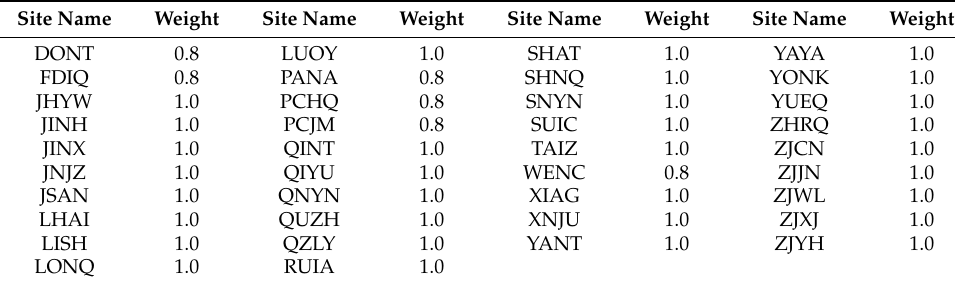
Table 3. The weights 38 CORS in the study area.